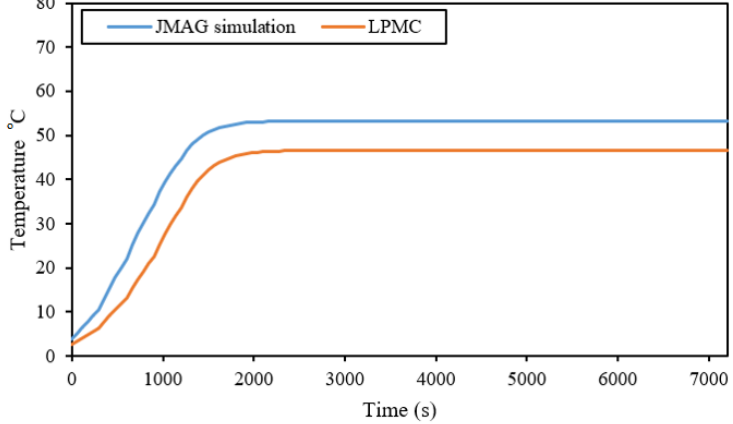
Figure 23. Average temperature rise comparison.